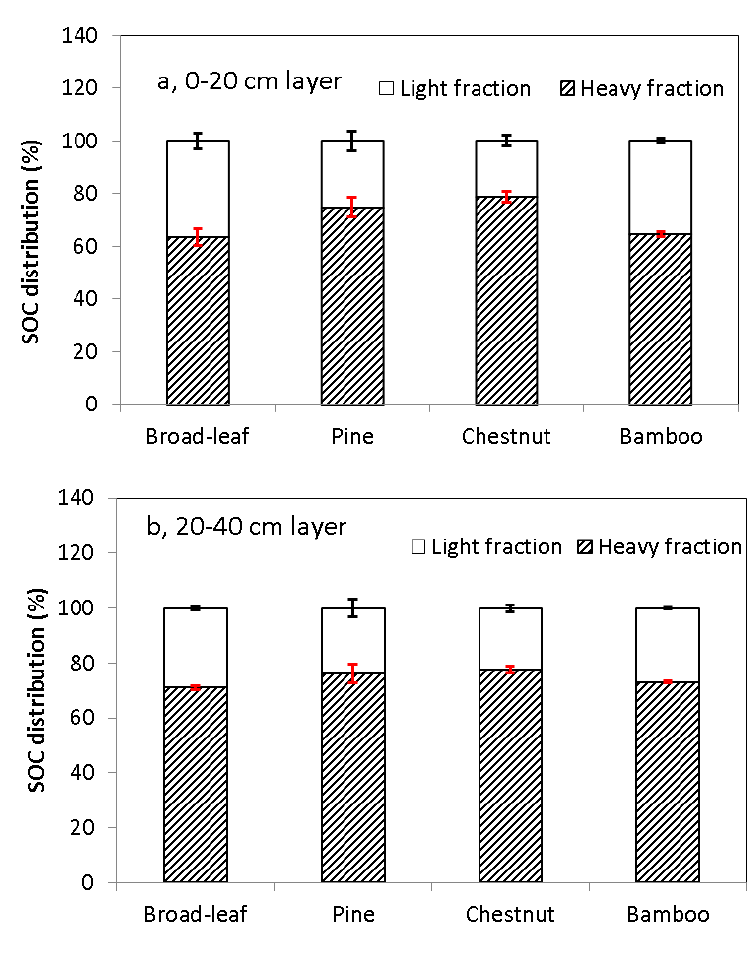
Figure 4. Mean distribution of organic carbon in light and heavy fractions in the ( a ) 0–20-cm soil layer and ( b ) 20–40-cm soil layer under four types of forest vegetation-land